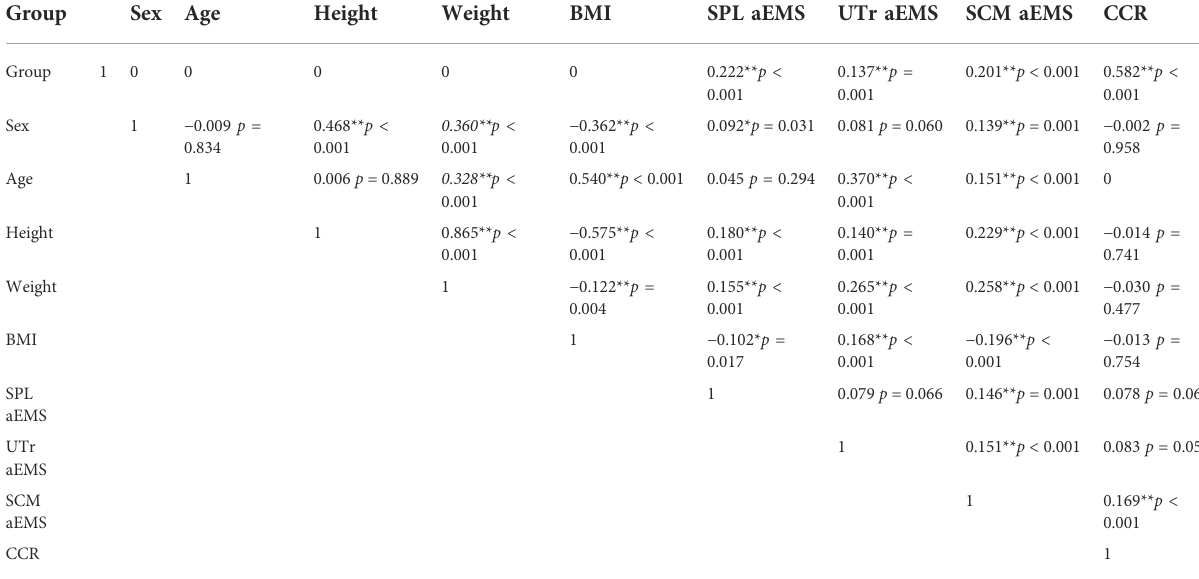
TABLE 3 Correlation analysis of the aEMG, CCR and general characteristics.